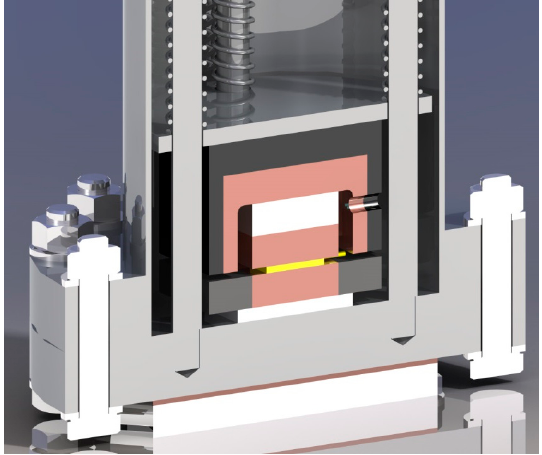
Figure 4. Test bed for characterisation of thermoelectric generators; the TEG is coloured yellow.